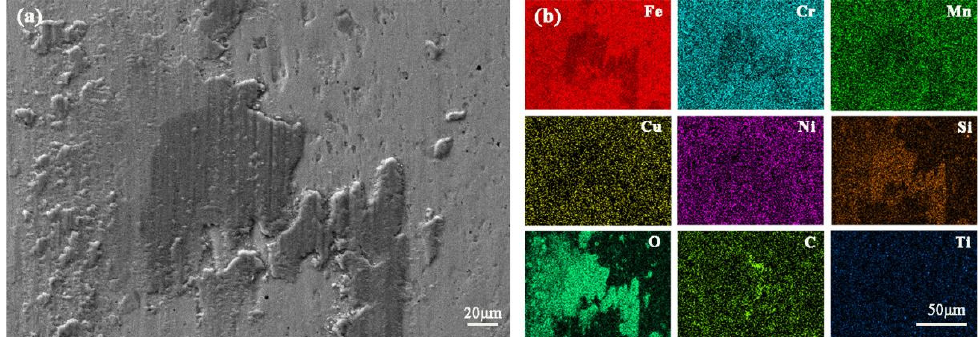
Figure 8. Wear morphology and surface element distribution of the high-entropy alloy coating at a melting current of 240A. ( a ) Wear marks SEM; ( b ) Wear marks EDS surface scan.